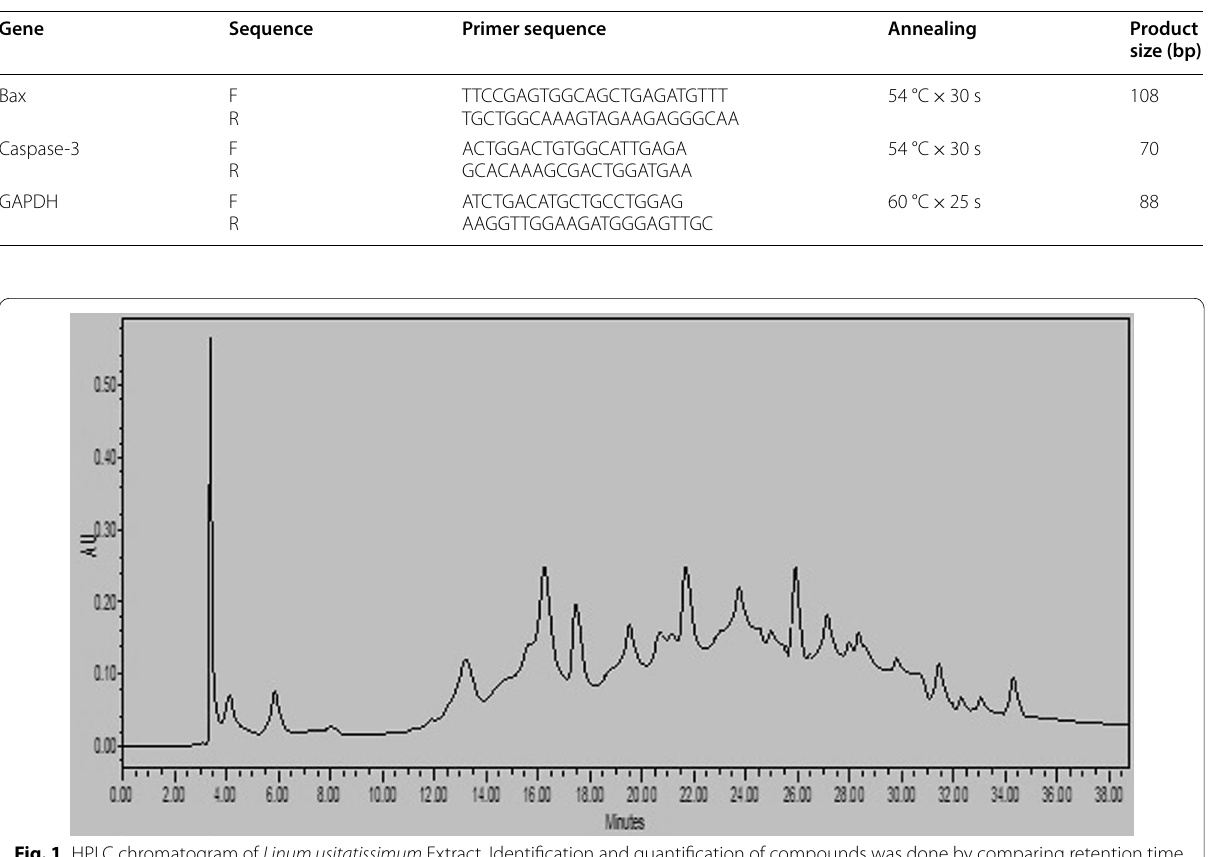
Table 1 Primer sequences of Bax, Caspase-3, and GAPDH